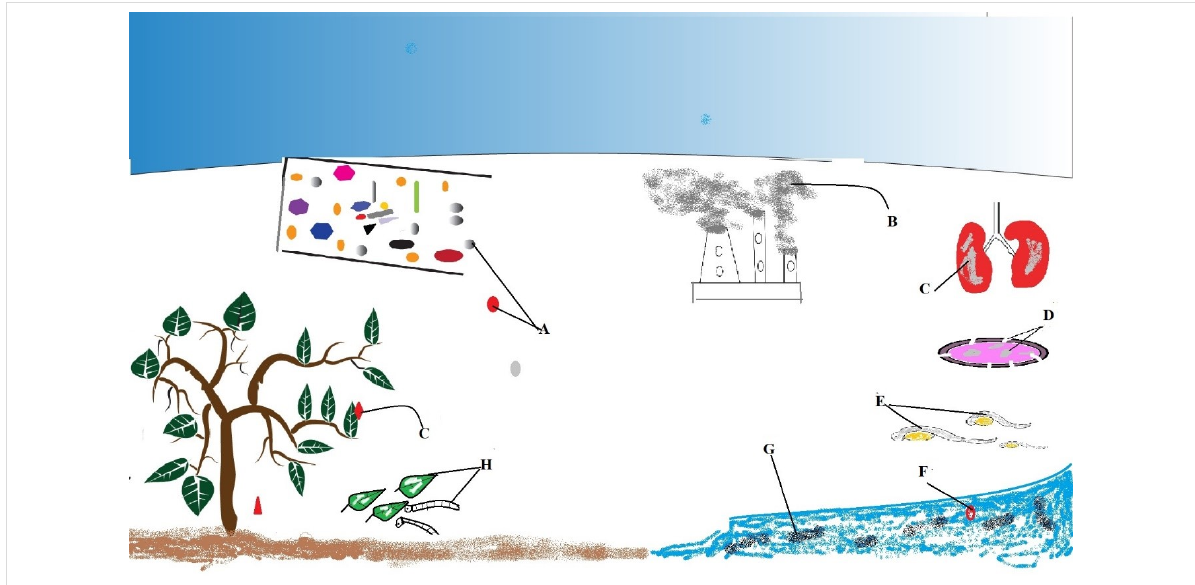
Figure 1: The effects of nanomaterials on the environment and on human and animal health. (A) Nanomaterial waste; (B) fumes and gases from factories; (C) inflammation of the lungs after inhalation of gases/fumes or when in contact with nanomaterial waste; (D) damage in the membrane and in the lumen of silkworm silk glands; (E) dead zebrafish embryos; (F) NM; (G) contamination of water bodies; (H) silkworm feeding on mulberry leaves containing chemical